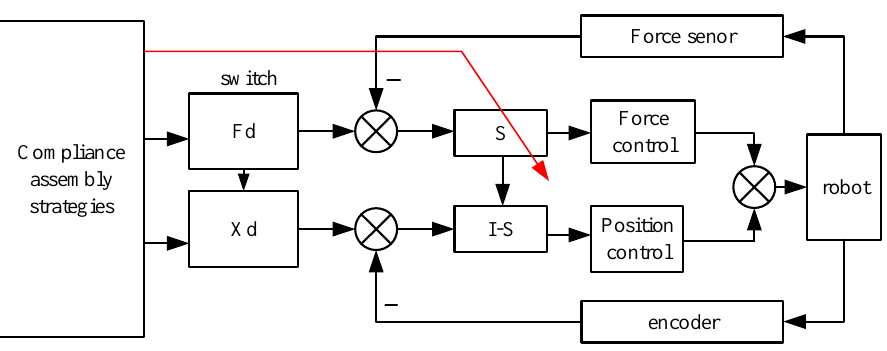
Figure 11. The block diagram of the control system.